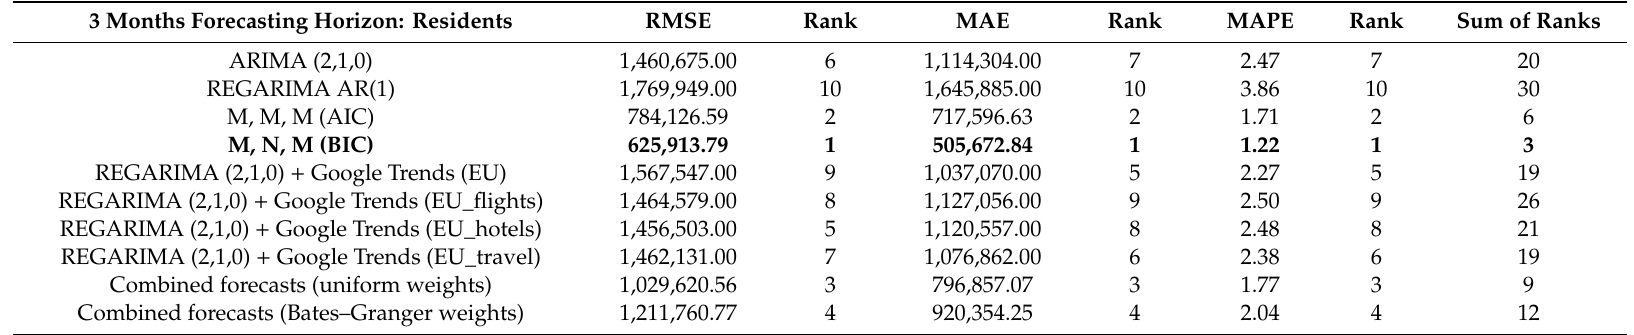
Table A3. Forecasting accuracy (December 2017): arrivals, residents, three months ahead. Source: European Commission (2017) and own calculations. Boldface indicates the single forecasting model(s) / forecast combination technique(s) characterized by the lowest sum of ranks. 3 Months Forecasting Horizon: Residents